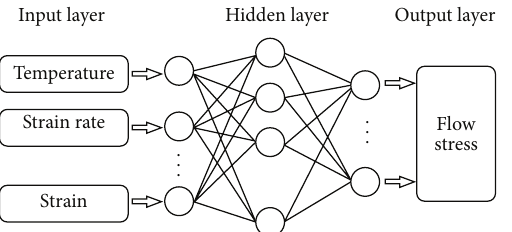
Figure 4: Schematic illustration of the neural network architecture.